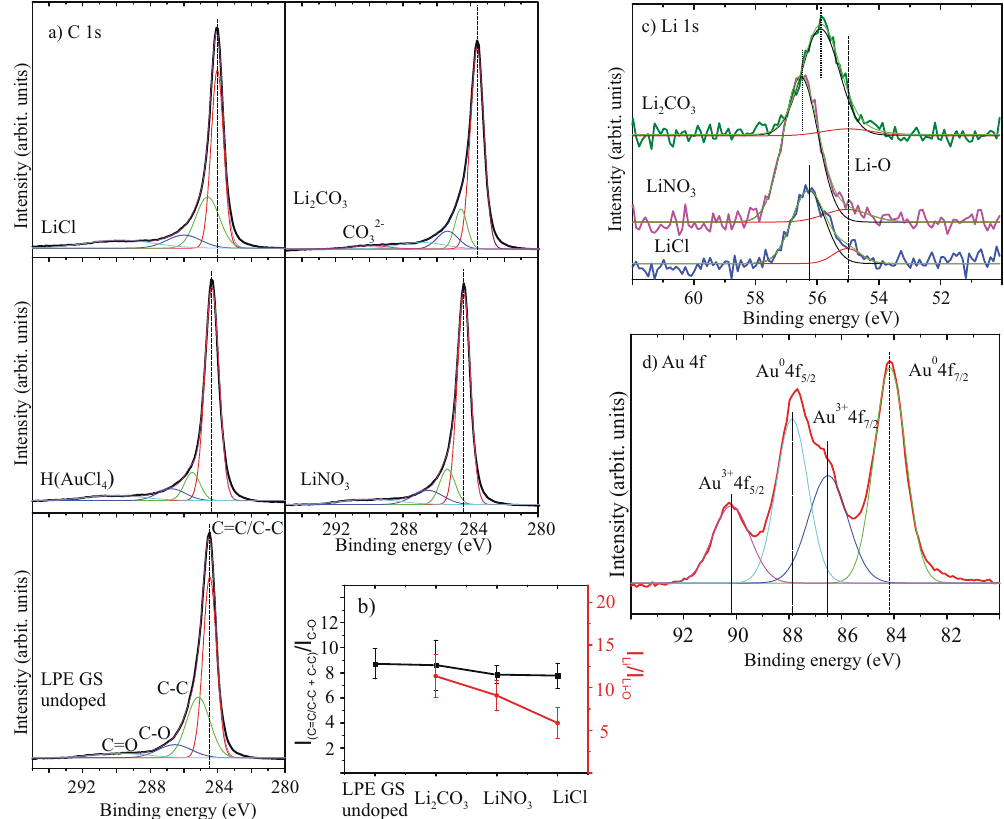
Figure 8. ( a ) XPS C 1 s spectra of undoped and H(AuCl 4 ), LiCl, LiNO 3 , Li 2 CO 3 doped LPE GS films. C = C/C–C in aromatic rings (284.5 eV); C–C sp 3 (285.4 eV); C–O (286.6 eV) and C = O (289 eV) were considered. For Li 2 CO 3 a small additional peak at 289.2–291.0 eV can be assigned to carbonate. ( b ) Peak intensity ratio for the sum of C = C/C-C and C-C peaks intensities, and the intensity of C-O, I (C = C/C-C + C-C) /I (C-O) (black line) and the ratio of Li 1 s intensity from Li salts to Li-O intensity, I Li /I Li-O (red line). ( c ) XPS Li 1 s spectra for different Li compounds and for Li–O. ( d ) The Au 4 f peak in the XPS data of H(AuCl 4